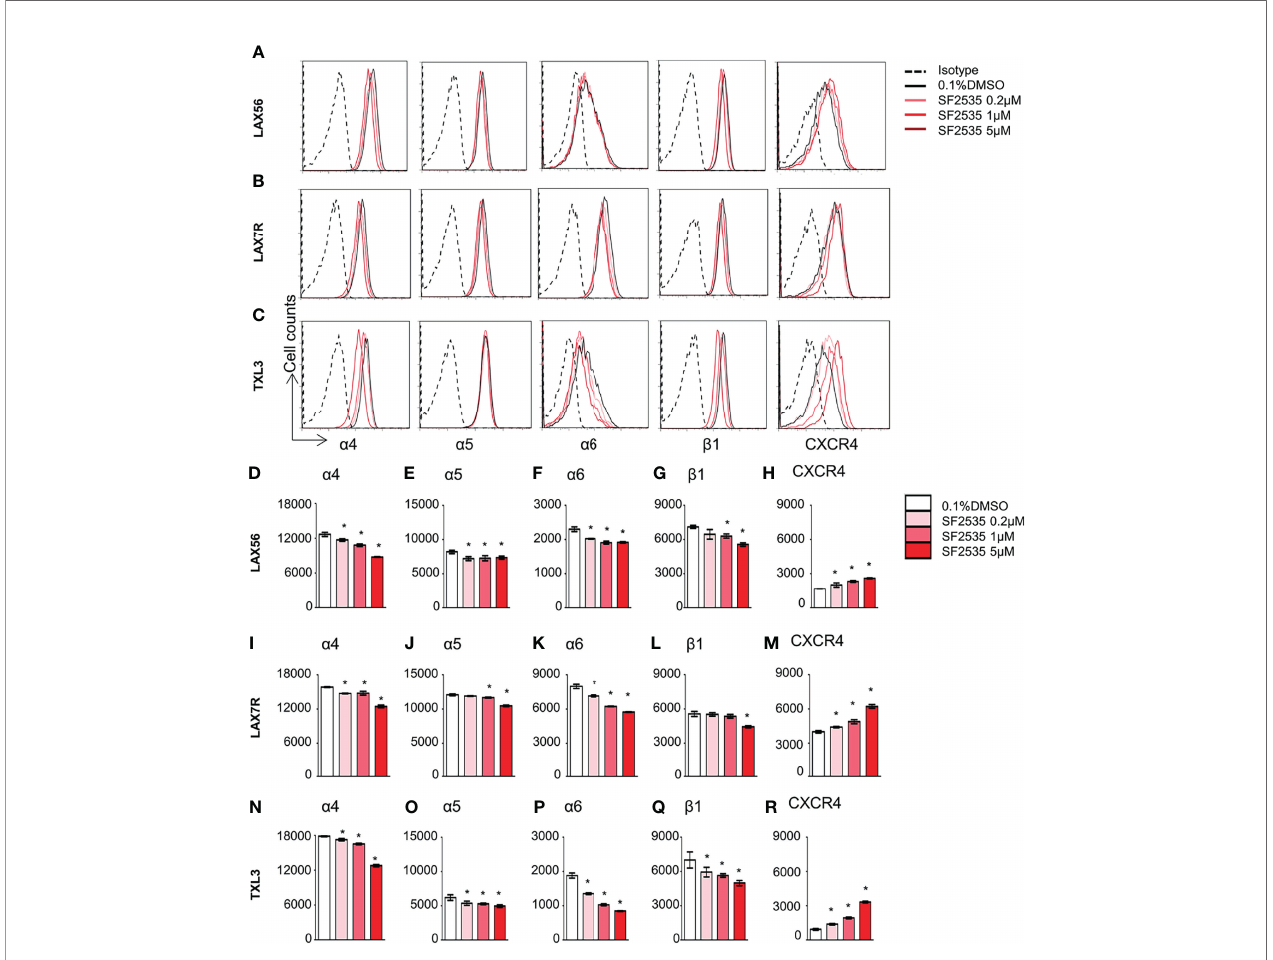
FIGURE 4 | SF2535 affects adhesion molecules. Representative histograms for integrin a 4, a 5, a 6, b 1, and CXCR4 expression for (A) LAX56, (B) LAX7R and (C) TXL3 cells were treated with 0.1% DMSO (in white bars) or SF2535 (0.2 m M, 1 m M, 5 m M in gradient red bars) for 24 hours. (D – R) Mean fl uorescence intensity (MFI) of integrin a 4, a 5, a 6, b 1, and CXCR4 were shown on indicated y-axis in (D – H) LAX56, (I – M) LAX7R and (N – R) TXL3 B-ALL cells. P-value *<0.05 compared to DMSO control. One representative experiment out of at least two independent experiments is